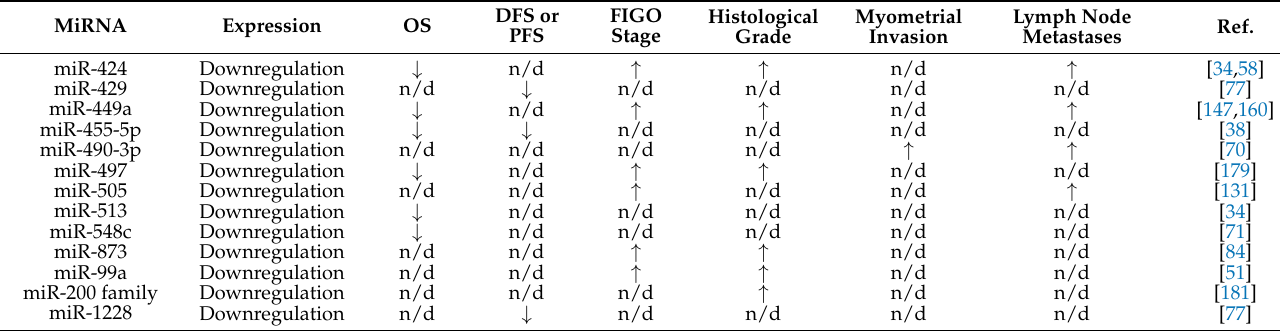
Table 4. Cont. FIGO Stage